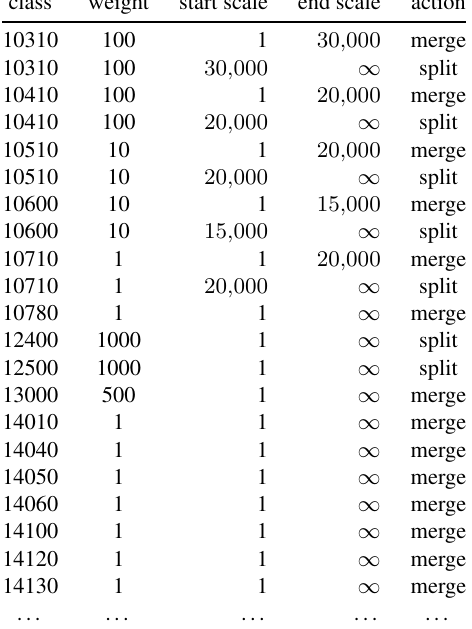
Table 2. Generalization actions. Parameters for the generalization process as can be specified. Note that the start scale and end scale columns contain the specification which generalization operation to carry out for which scale range. In case a polygon with the classification ‘local road’ (feature class 10510) is selected to be generalized, the operation that will be applied is merge (in the scale range 1:start scale – 1 : 20 , 000 ) or split (1 : 20 , 000 – 1 : ∞ ), dependent on the current estimated Table: class compatibility matrix The creation of the tGAP structure is driven by two main aspects. First, the global or- der of the features based on importance value, i.e. in every step the least-important feature is selected and processed (merge or split). Second, selection of the most compati- ble neighbour. To influence the decision, the compatibility matrix is used (see Table 3). Within the scale dependent